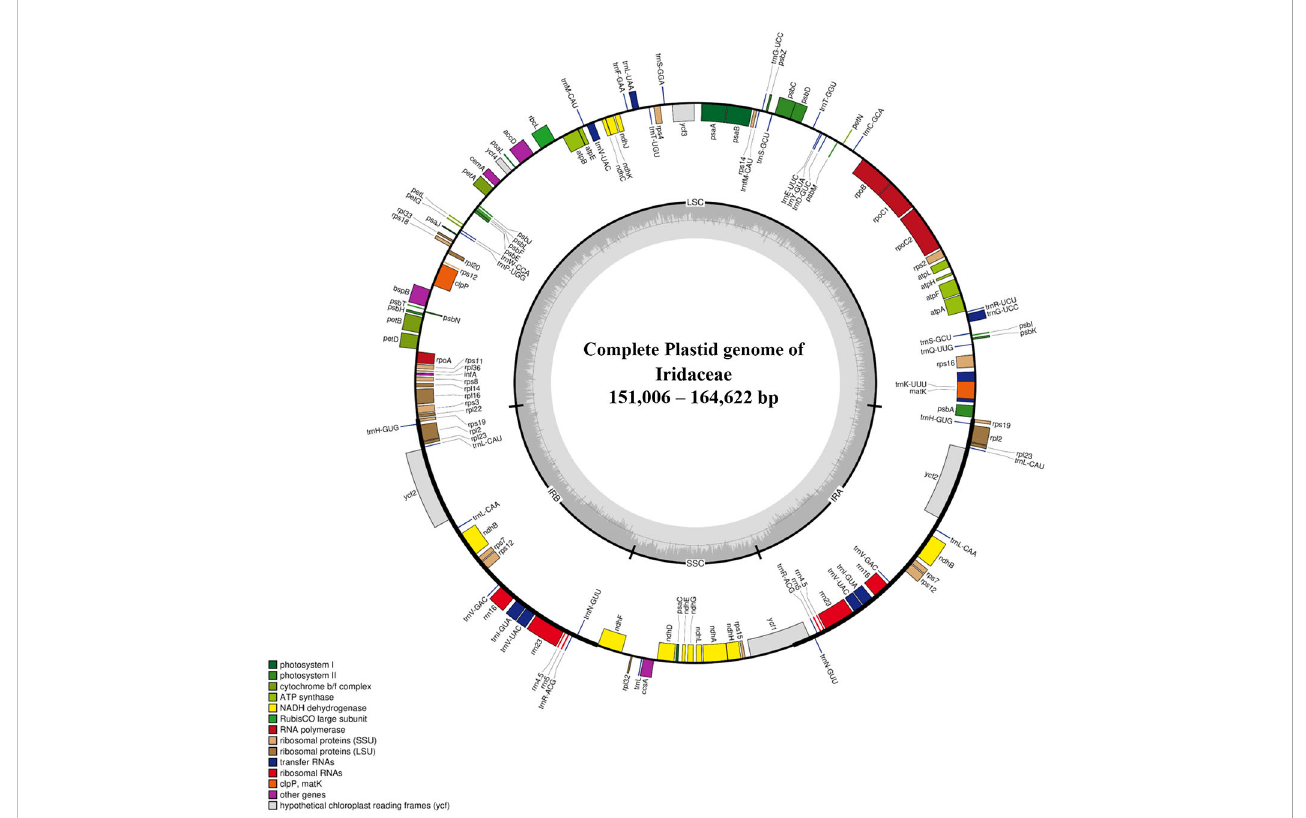
FIGURE 1 Representative chloroplast genome of Iridaceae. The colored bars indicate protein-coding genes, tRNA genes, and rRNA genes. Genes drawn outside of the map circle are transcribed clockwise, while that drawn inside are transcribed counterclockwise. The darker gray in the inner circle corresponds to the GC content, while the lighter gray corresponds to the AT content.